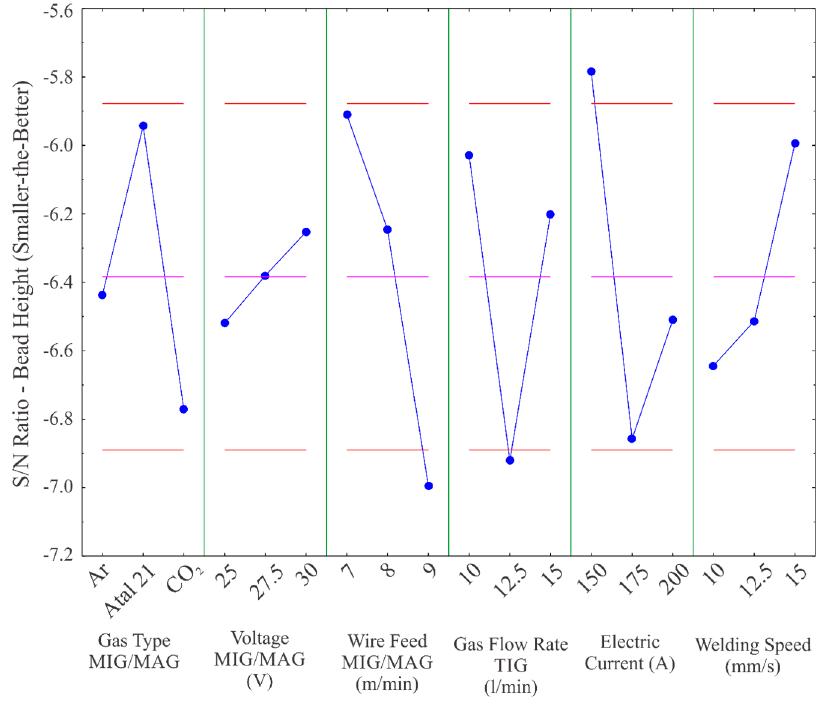
Figure 13. S/N ratio to obtain the lowest bead height of the weld bead.